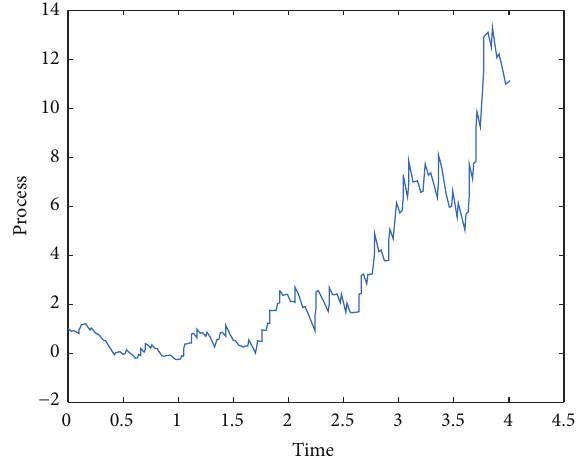
Figure 1: Diffusion approximation with epsilon = 0.1.